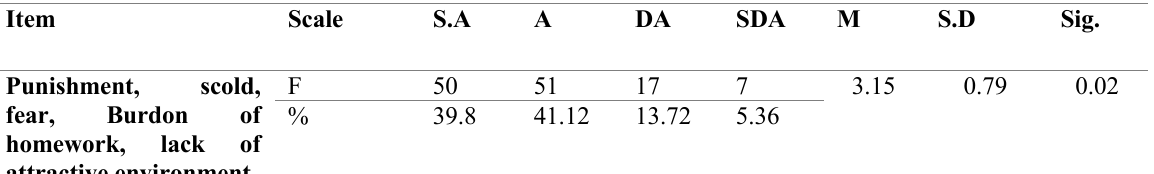
Table 1: Teachers opinion about the passive attitude